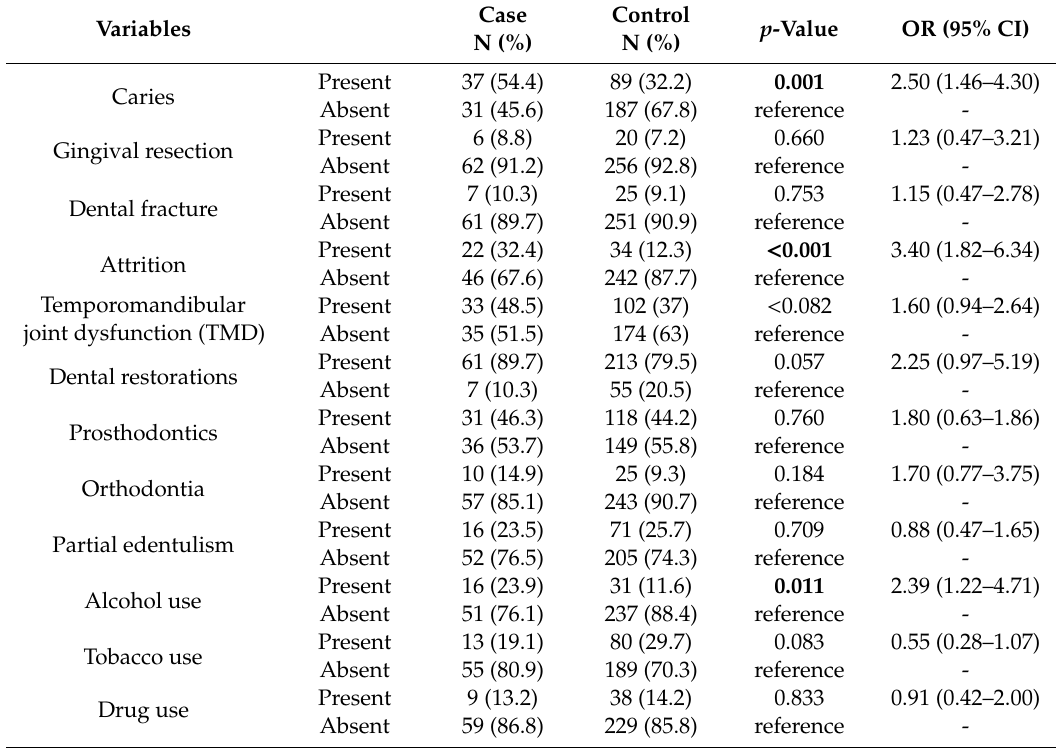
Table 2. Comparison of dental characteristics and habits between adults with bruxism (cases) and individuals without bruxism (control).